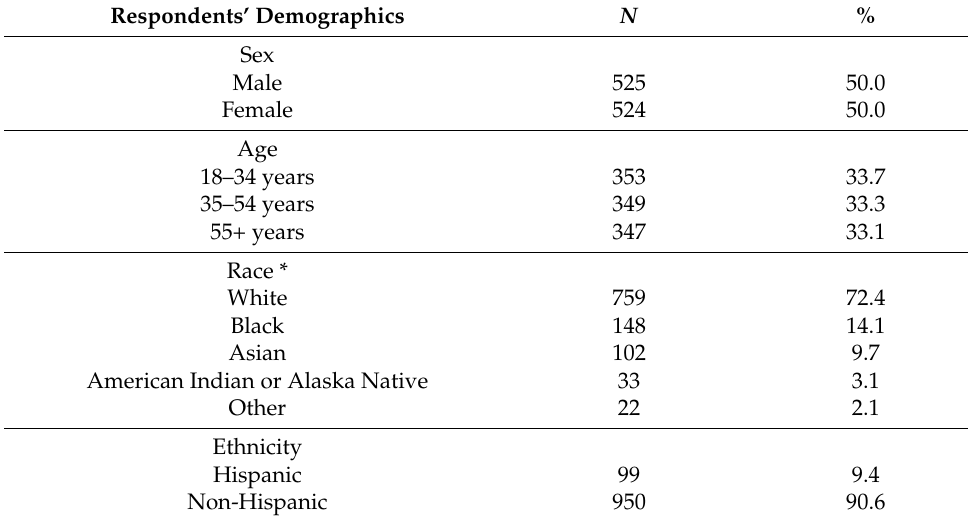
Table 1. Demographics of respondents prior to weighting ( N =